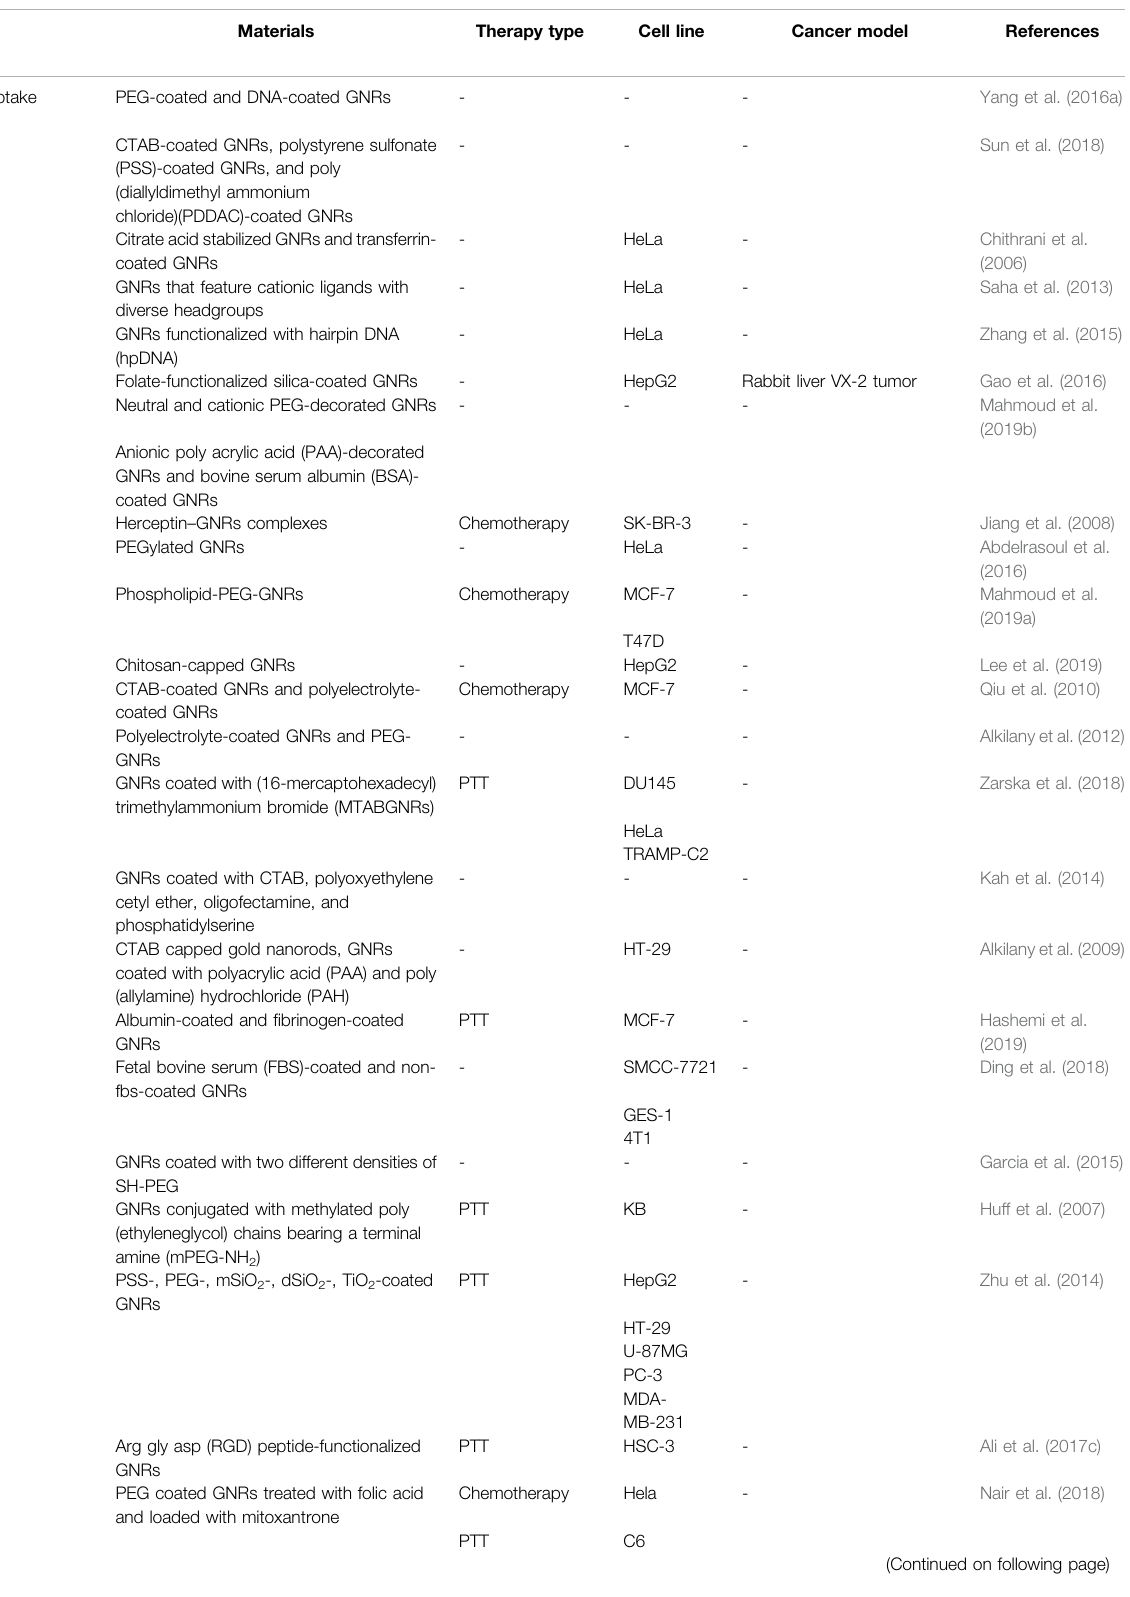
TABLE 2 | Summaries of functionalization of gold nanorods aimed at speci fi c procedures of photothermal therapy. The speci fi c